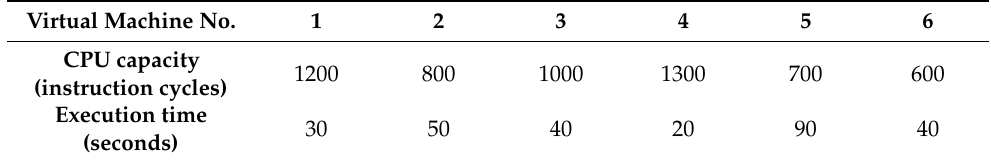
Table 6. Configuration of 6 virtual machines for scenario